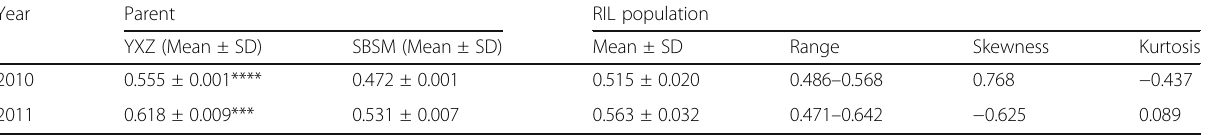
Table 1 The harvest index of YXZ, SBSM and their derived RIL population in the two-year experiments